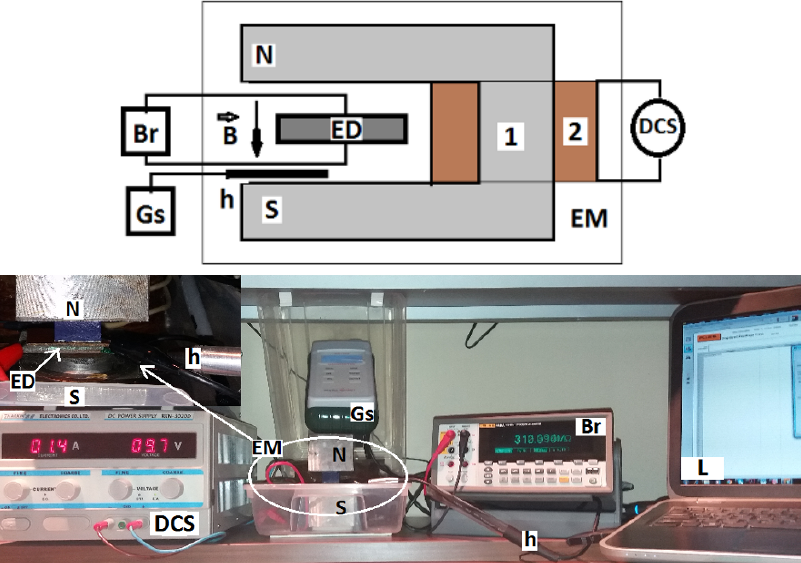
Figure 7. (Upper part) Overall configuration of the experimental setup. 1—magnetic yoke;